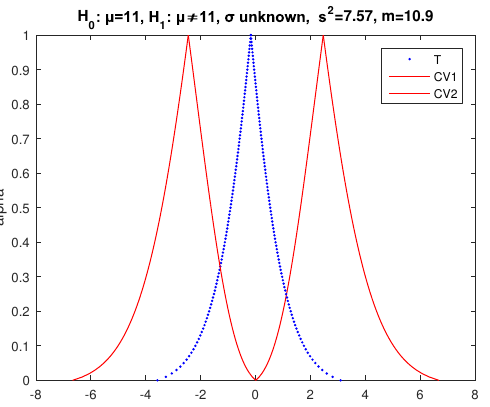
Figure 14. The possibility distribution of the fuzzy statistic T and the fuzzy critical values for the respective test of [15] of H 0 of Example 5.